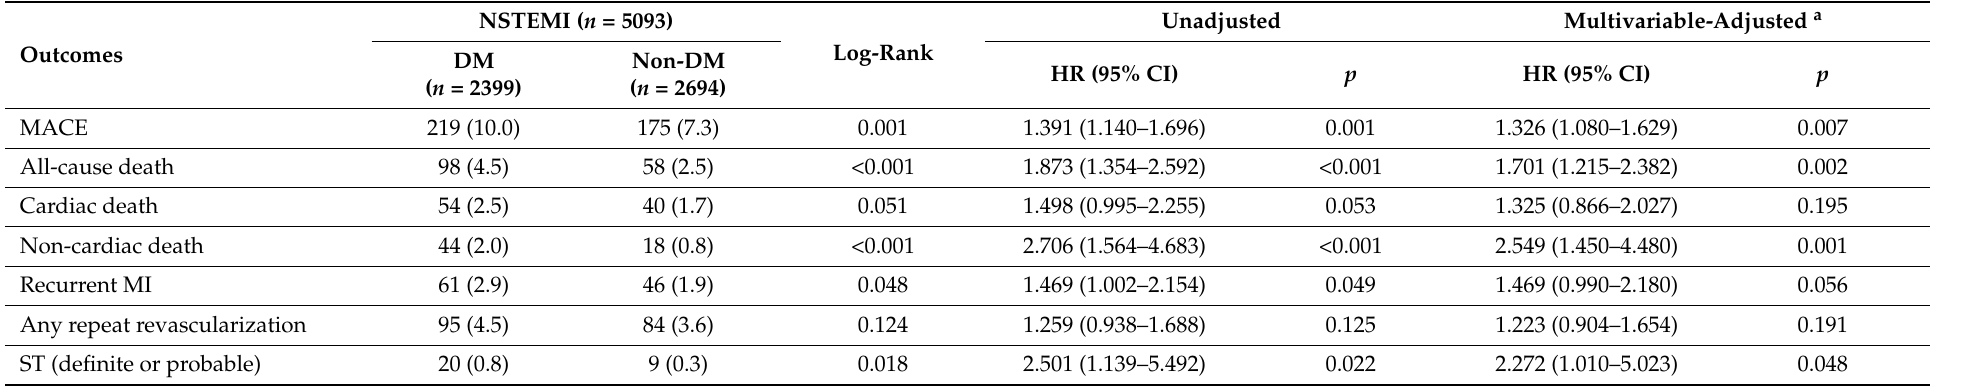
Table 3. Clinical outcomes between the DM and non-DM groups at 2